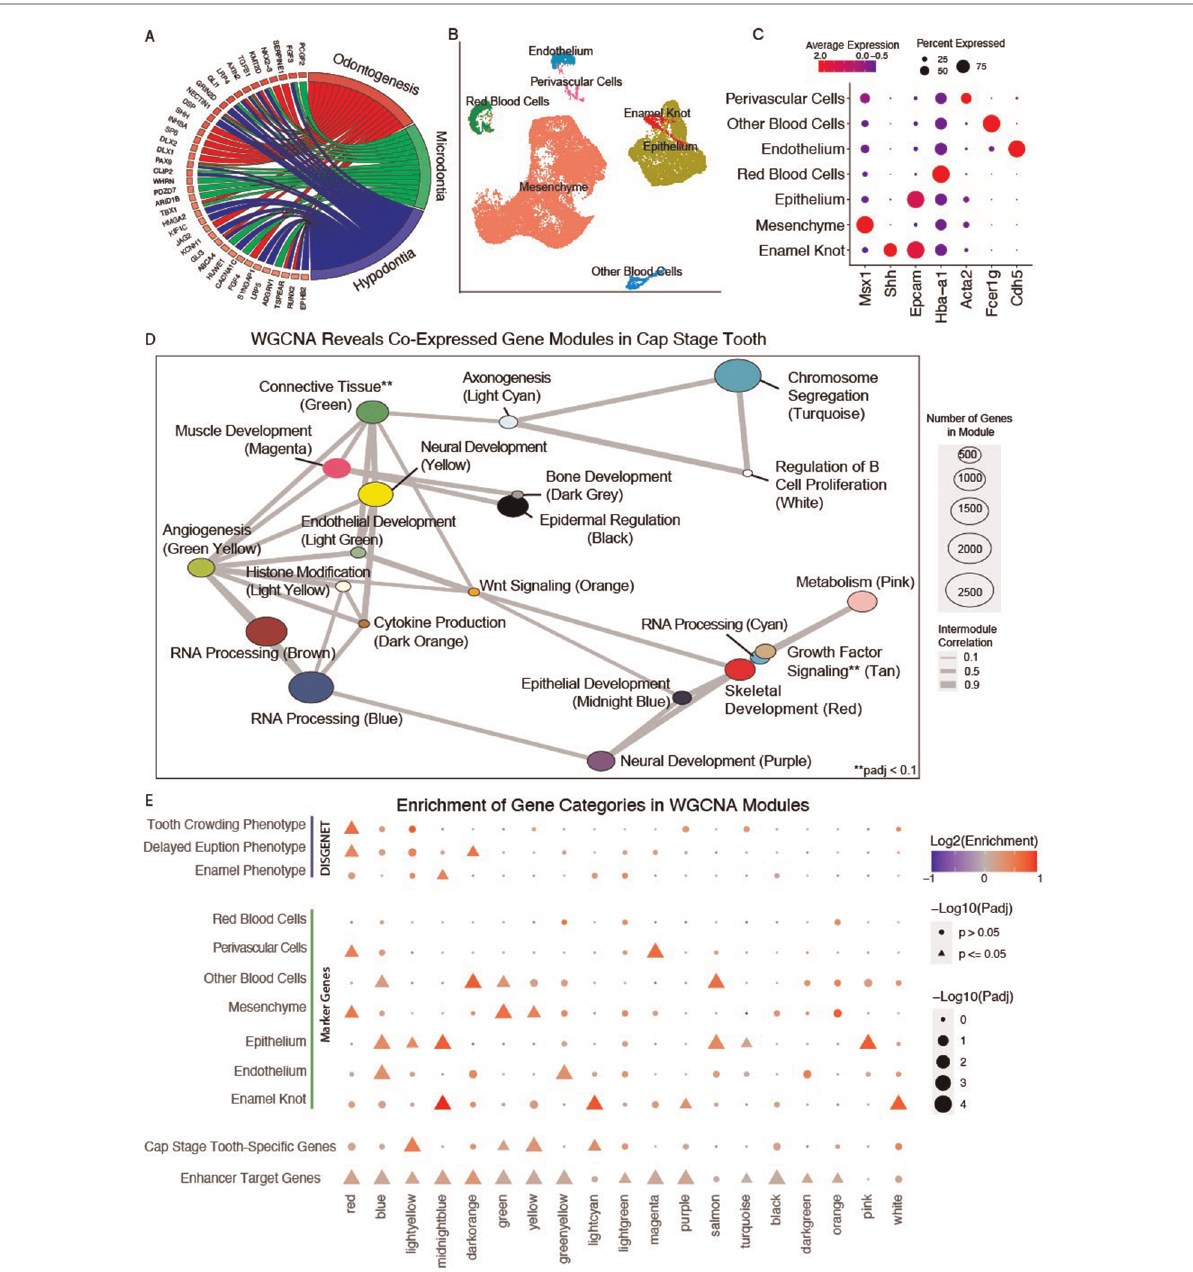
FIGURE 3 Weighted gene co-expression network analysis reveals dental development-speci fi c coExpression modules. ( A ) Gene ontology map of genes differentially expressed in the cap stage tooth. ( B ) Annotated UMAP of cell types determined through Seurat analysis of 4 replicates of E14 mouse mandibular molars ( n =33,886 cells) from (62). ( C ) Dotplot of expression per annotated cluster from B for canonical dental cell type marker genes. Size is equivalent to percent expression, color is equivalent to expression. ( D ) Network plot of co-expressed modules of genes identi fi ed through WGCNA on embryonic mouse mandibular tooth samples from molars (E12.5 – E17.5) and incisors (E12.5). A Pearson correlation of the module eigenvectors was calculated for the edges, and positive correlations of ≥ 0.5 were included. The location of each module is determined by multidimensional scaling (MDS) of the module eigengene vectors. Size of dots indicates the number of genes in each module, and colors are module names assigned by WGCNA. Modules are labeled according to module name and the most representative signi fi cantly enriched GO term of that module, as determined by clusterPro fi ler. ( E ) Permutation enrichment analysis ( n =10,000) of genes from each module within TSE target genes, and of human dental disease ontology categories, cap-stage differentially expressed genes, and marker genes identi fi ed from clusters in ( B ). Point size and shape indicates the signi fi cance of this enrichment, and color indicates the directionality of that enrichment (positive or